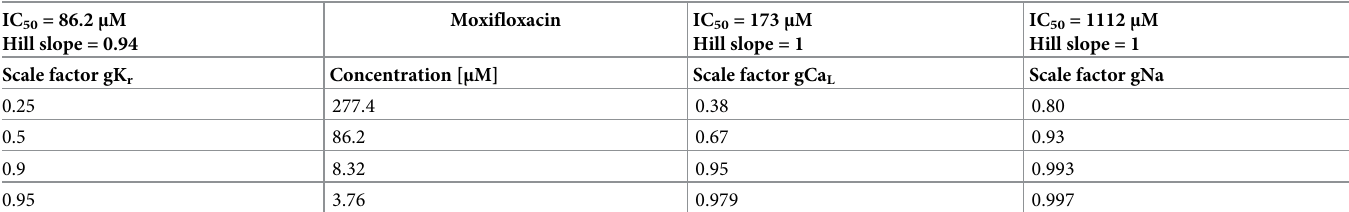
Table 2. Scale factors used to simulate pharmacological manipulation with Moxifloxacin. IC 50 = 86.2 μ M Hill slope = 0.94